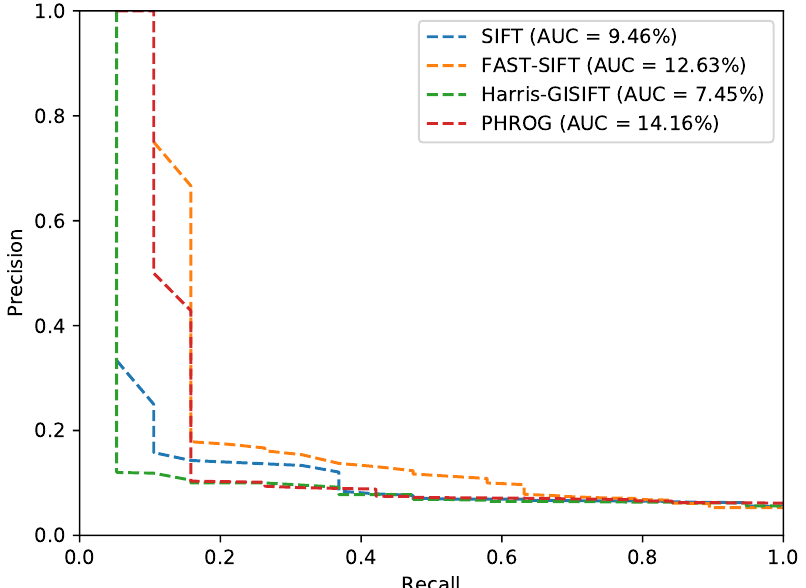
Figure 21. Precision-Recall curves from the “VPRiCE” dataset and AUC ( Area Under the Curve ) for each method.